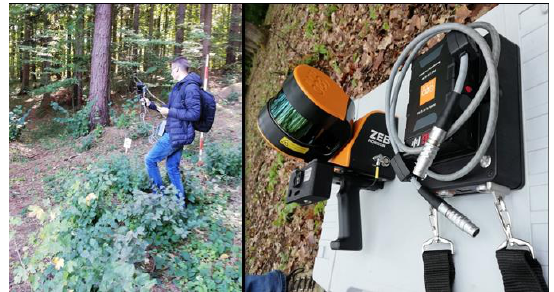
Figure 2. Left side – ZEB REVO in data acquisition process; Right side – ZEB HORIZON